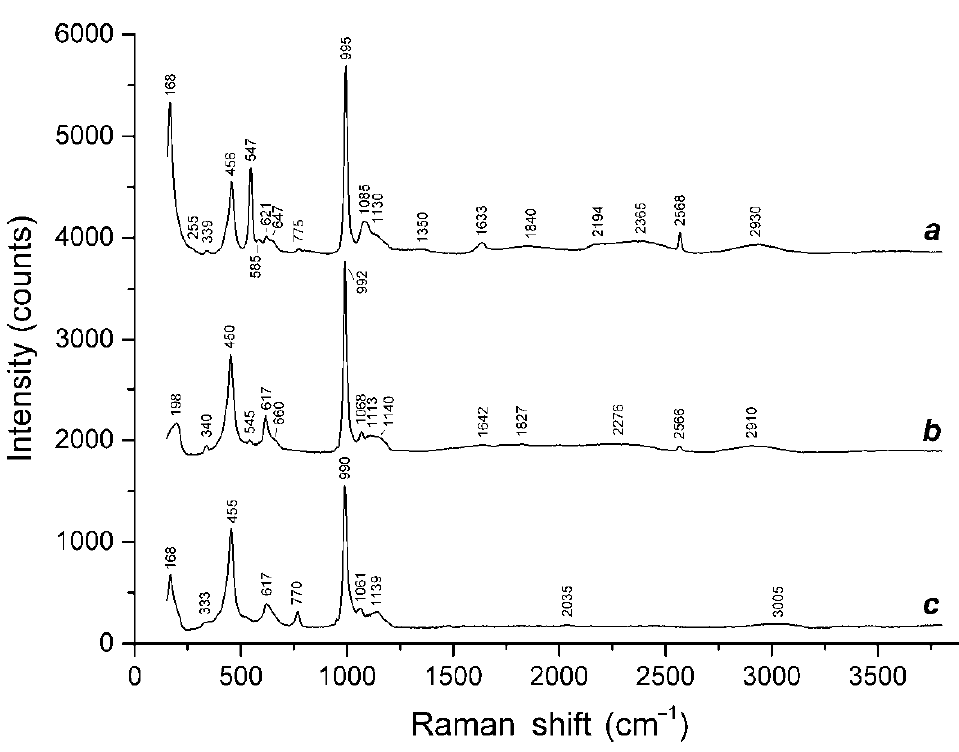
Figure 12. Raman spectra of the afghanite Samples 10 ( a ), 9 ( b ) and 11 ( c ).